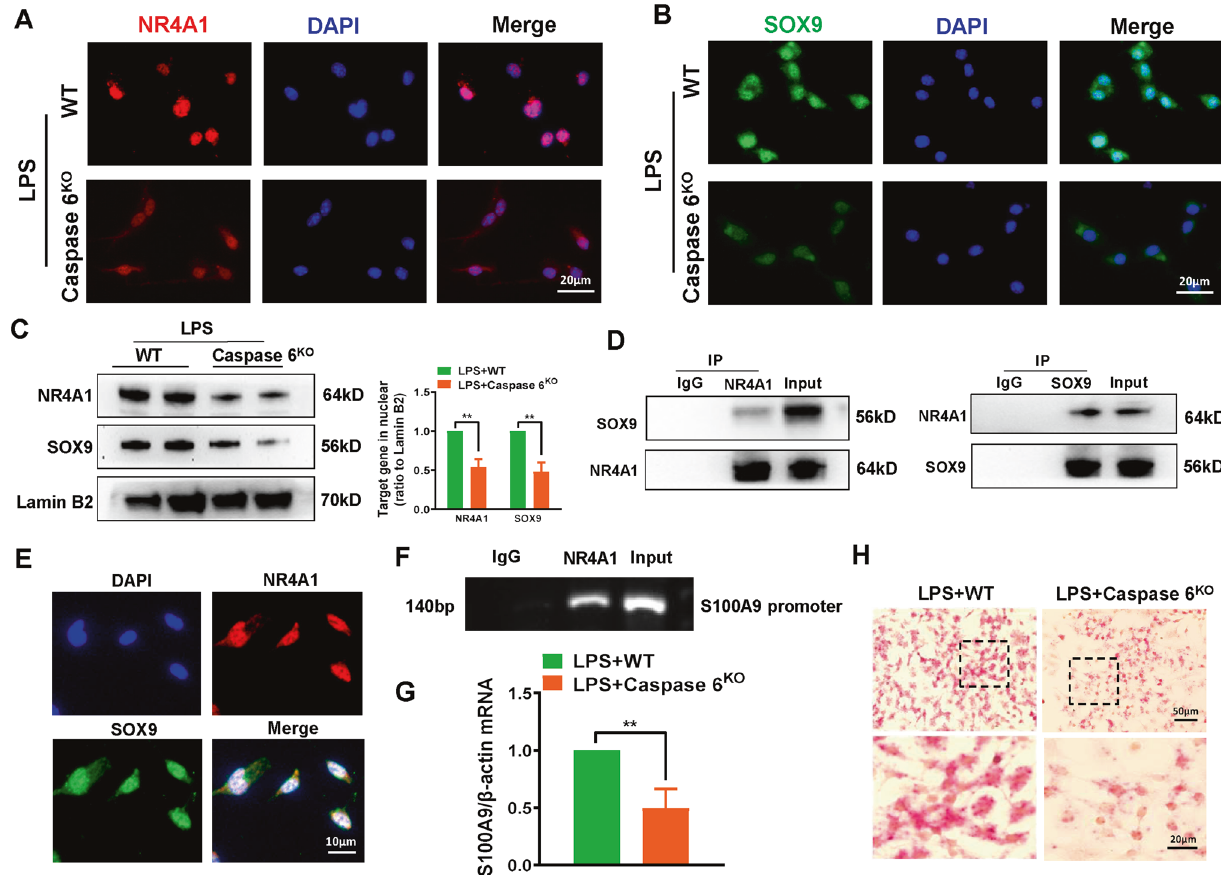
Fig. 5 NR4A1 interacts with SOX9 in nuclear to target S100A9 transcription in macrophages. Bone marrow-derived macrophages (BMMs) derived from WT or Caspase 6 KO mice were treated with LPS for 6 h. IF staining of NR4A1 ( A ) and SOX9 ( B ) in LPS-stimulated macrophages. DAPI was used to visualize nuclei (blue). Scale bars: 20 μ m. C Western-assisted analysis of NR4A1 and SOX9 in nuclear extracts; ( D ) Immunoprecipitation analysis of NR4A1 and SOX9 in LPS-stimulated macrophages from WT and Caspase 6 KO mice. E IF staining for macrophage NR4A1 (red) and SOX9 (green) co-localization in the nuclear after LPS stimulation, scale bar: 10 μ m; ( F ) ChIP assay with macrophages using anti-NR4A1 antibody in LPS-treated BMMs; ( G ) RNA-ISH detecting S100A9 mRNA in macrophages by using speci fi c probe; ( H ) Detection of S100A9 mRNA by qRT-PCR in macrophages. N = 4 – 7/group, all data represent the mean ± SD, * p < 0.05, ** p < 0.01, *** p <